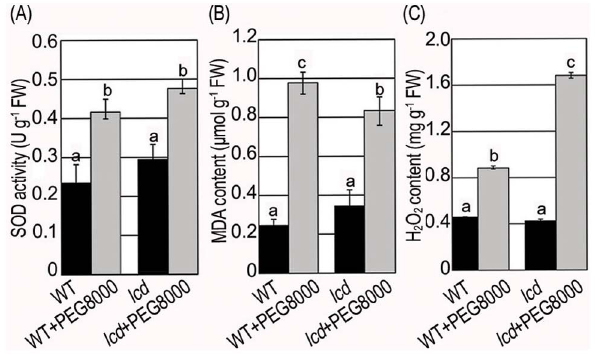
Figure 8. SOD activity, H 2 O 2 content and MDA content in WT and lcd plants treated with PEG8000. ( A ) SOD activity was measured in WT and lcd plants treated with 0.2 g ml 2 1 PEG8000 for 2 h. One SOD unit was the amount of enzyme required to inhibit photoreduction of nitro blue tetrazolium chIoride by 50% at 25 u C. SOD activity was expressed as U mg 2 1 (protein) min 2 1 . ( B ) H 2 O 2 content was measured in WT and lcd plants treated with 0.2 g ml 2 1 PEG8000 for 2 h. ( C ) MDA content was measured in WT and lcd plants treated with 0.2 g ml 2 1 PEG8000 for 2 h. Results are shown as mean 6 SE (n=3 independent experiments). Letter numbers indicate significant differ- ences between treatmeats ( P , 0.05 ).